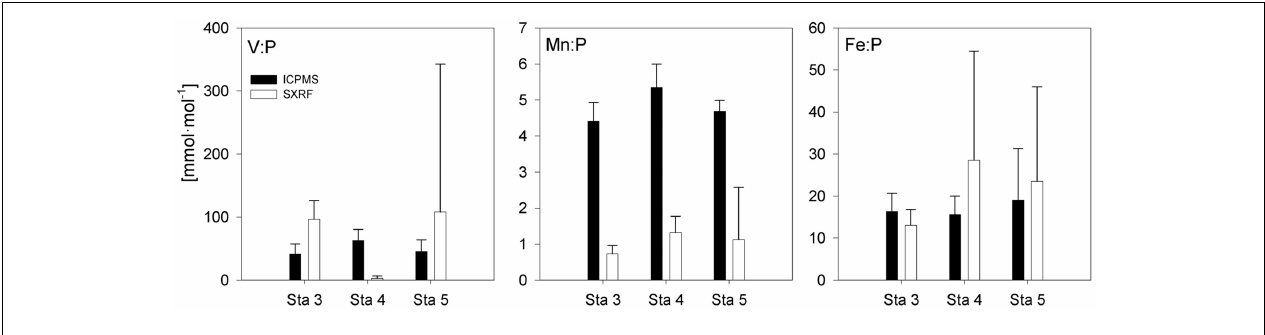
FIGURE 2 | P-normalized metal quotas of Trichodesmium as determined by ICP-MS and SXRF on samples collected at the same station. The bars are means ± SD for replicate filters (ICP-MS) or for